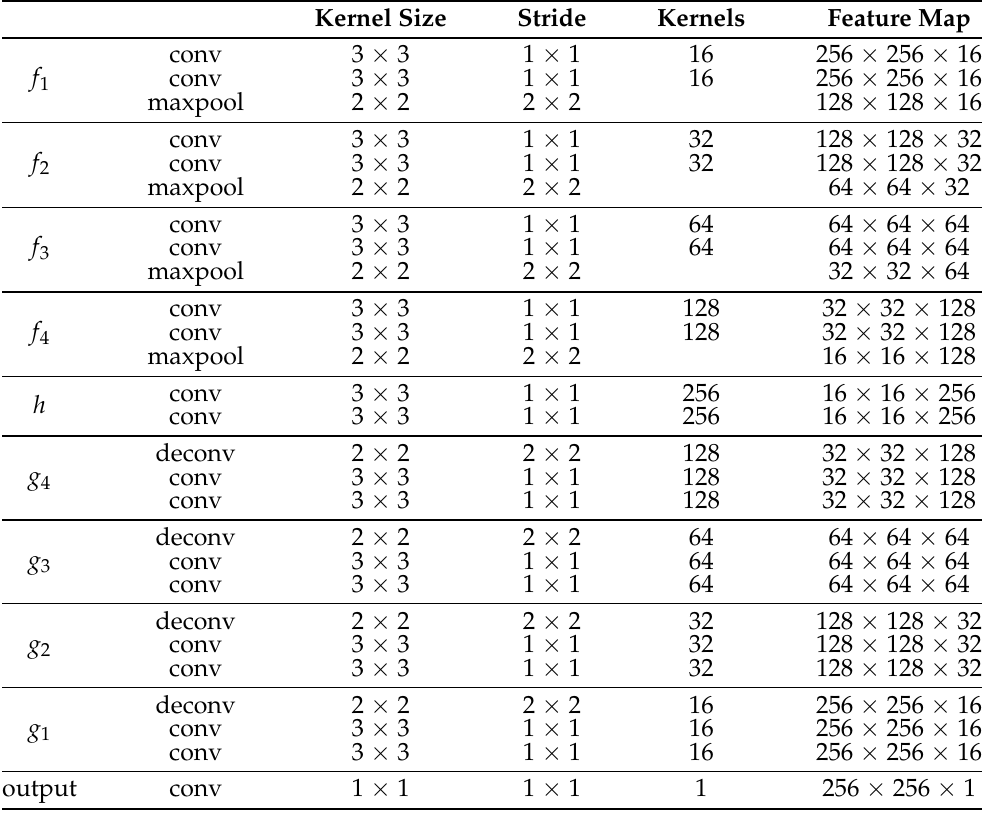
Table 1. Detailed architecture of the segmentation network for lung segmentation, representing a kernel size, stride, the number of kernels, and size of output feature map of each layer.